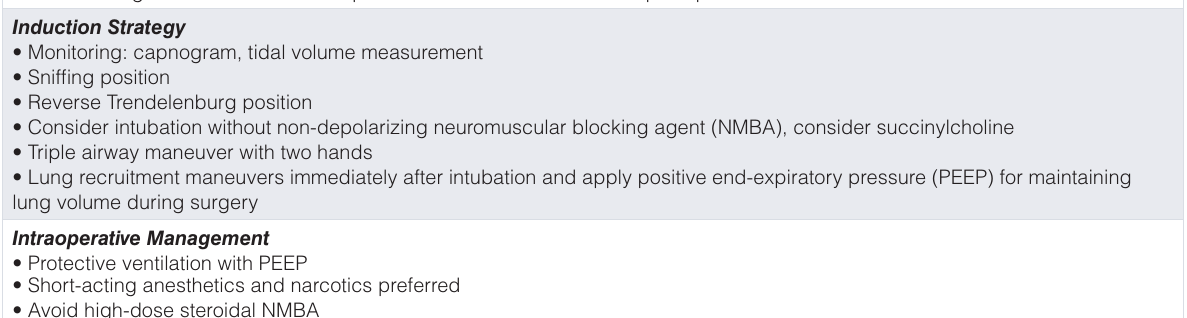
Table 4. Perioperative OSA Bundle (adopted from Dr Shiroh Isono, personal communication with Dr Matthias Eikermann). Preanesthesia